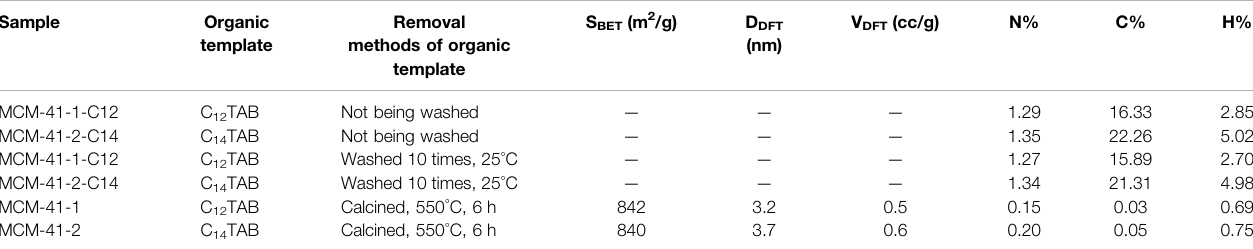
TABLE 1 | Characteristic structural parameter of the MCM-41 samples and removal methods of organic template. Sample Organic Removal template methods of organic